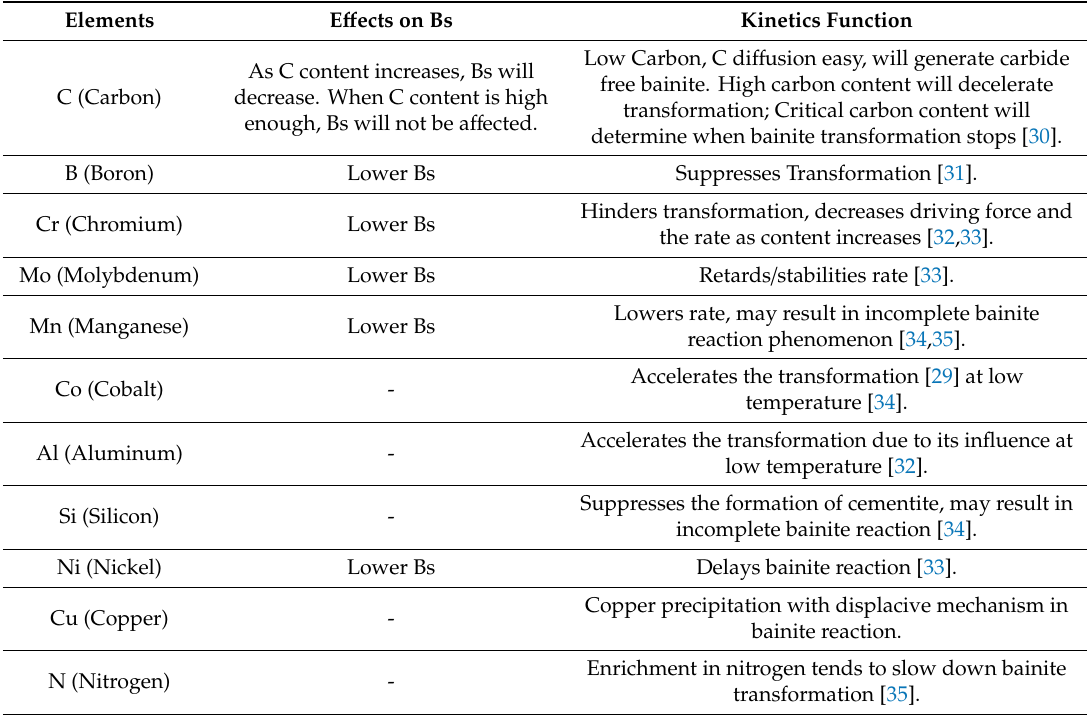
Table 1. E ff ects of alloying elements on bainite transformation